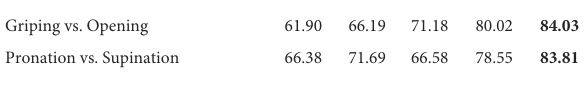
TABLE 9 Comparative accuracy ( % ) with other features in linear discriminant